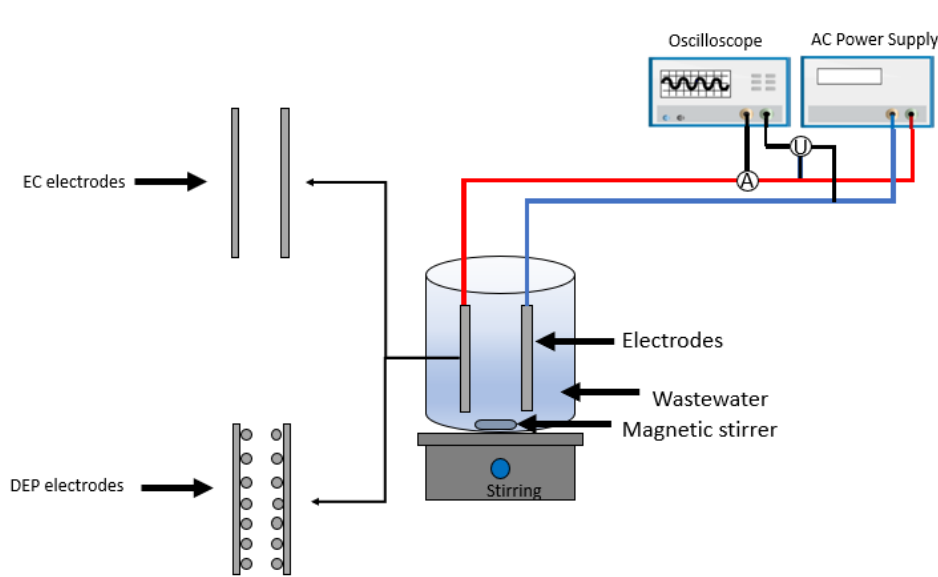
Figure 2. A schematic sketch for the bench-scale electrocoagulation setup used in this study. The removal percentage of heavy metal was calculated using Equation (8).